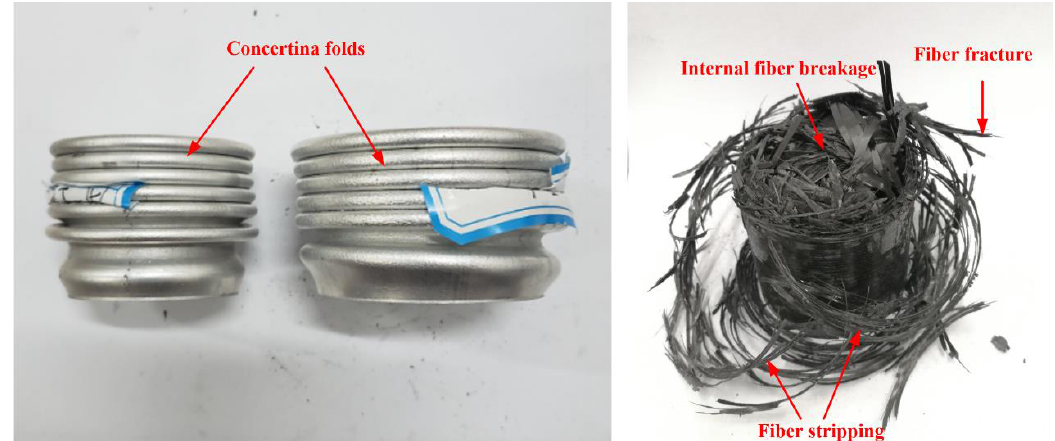
Figure 6. Crushing failure modes of aluminum alloy and CFRP tubes.